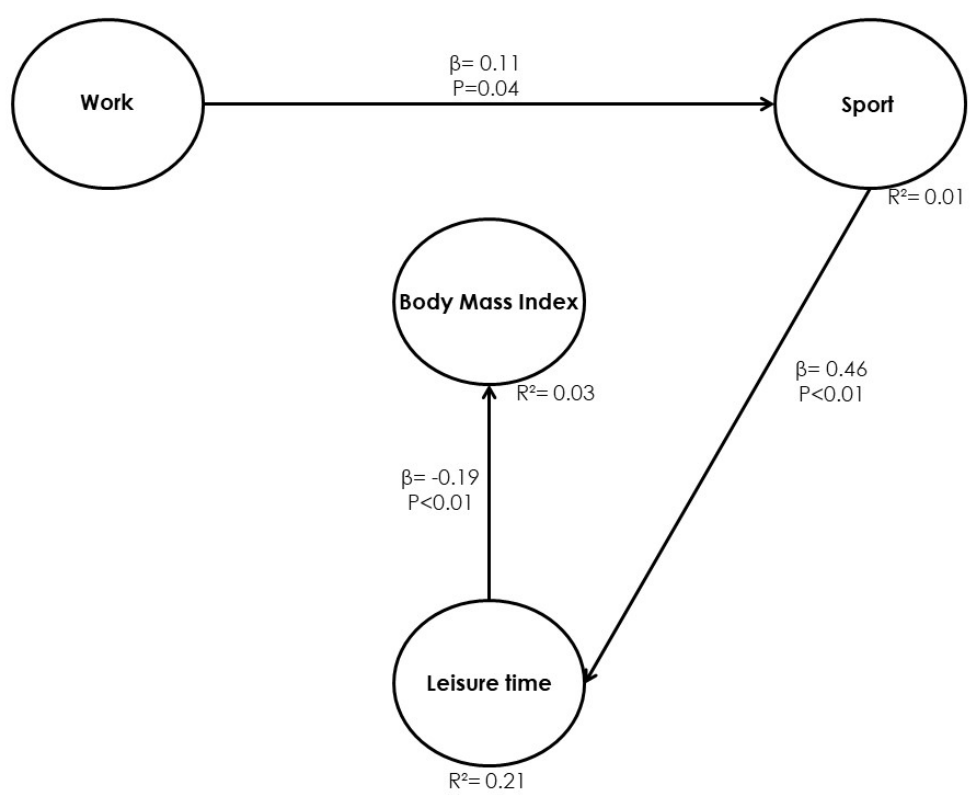
Figure 4. Final Model 2 for the relationships between the physical activity dimensions and BMI. BMI of obese managers’ sample = −0.19 × leisure-time + Error